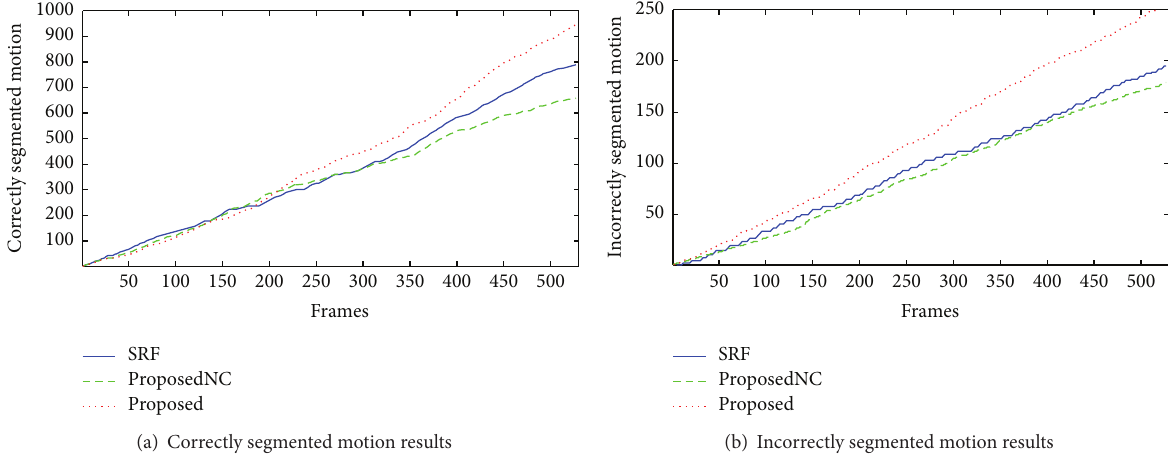
Figure 5: Comparison of segmentation results by using SRF (blue), proposed method (red), and proposedNC (green).